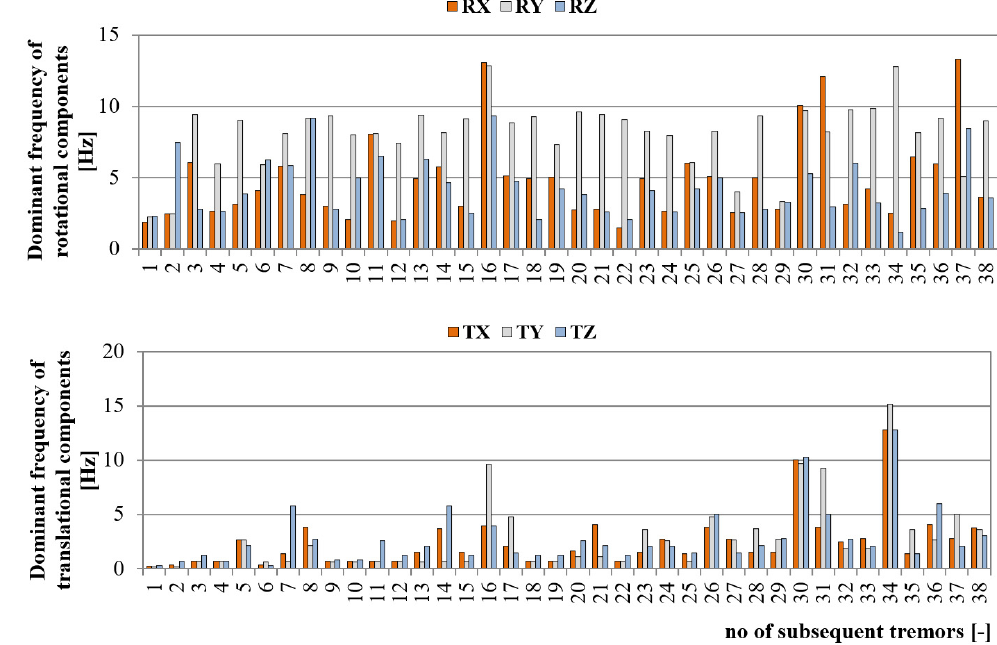
Figure 10. Dominant frequency of six components of seismic wave recorded at the slope of Zelazny Most.